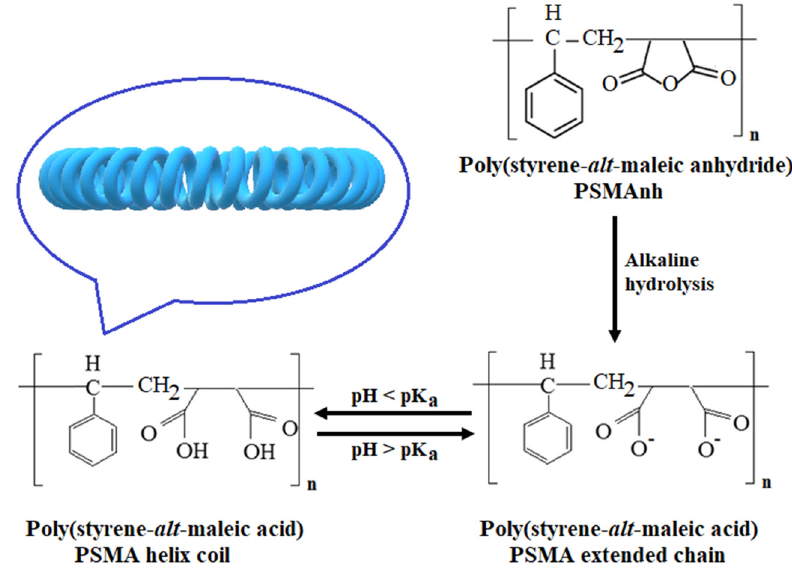
Figure 1: Formation of an extended PSMA chain upon alkaline hydrolysis of poly ( styrene - alt - maleic anhydride ) precursor and its confor - mational transition into a surface active α - helix